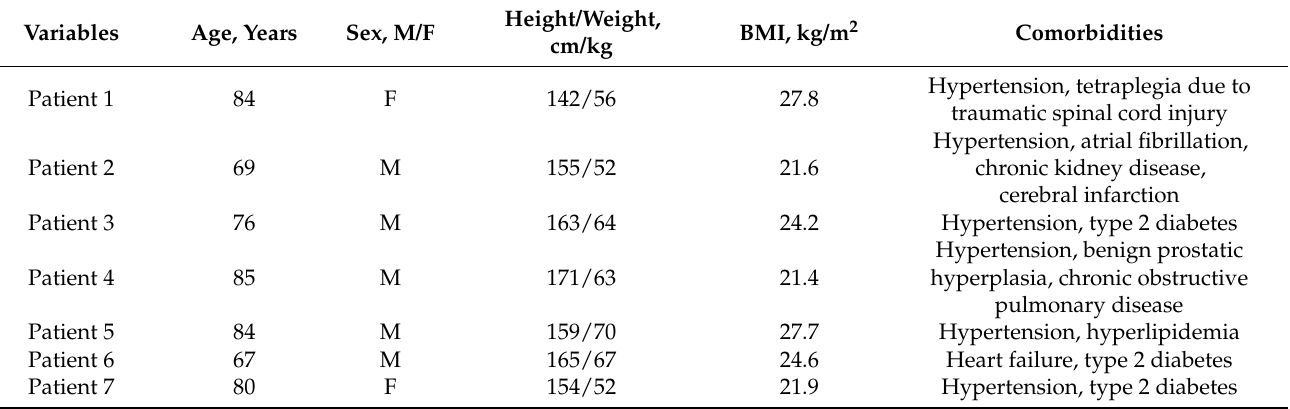
Table 1. Demographic Data of patients.